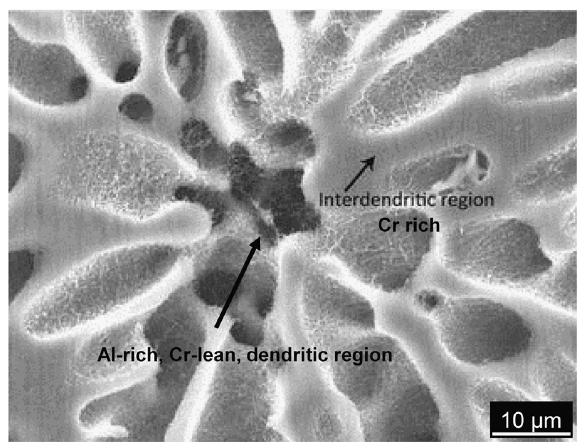
Fig. 7 The surface of an as-cast AlCoCrFeNi specimen after the potentiodynamic polarisation testing in 0.6 M NaCl. The image shows that the Cr-depleted dendrites experience selective dissolu- tion, while the Cr-rich interdendritic regions remained largely unaffected (reprinted from ref. 48 with permission of